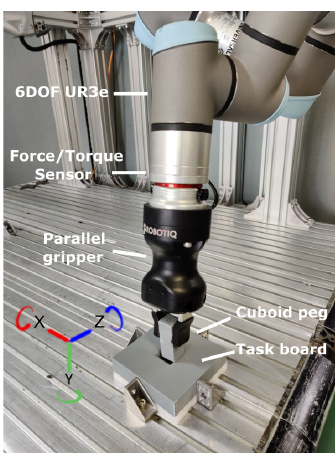
Figure 5. Real experiment environment with a 6-degree-of-freedom UR3e robotic arm. Cuboid peg and task board hole had a nonsmooth surface with 1.0 mm